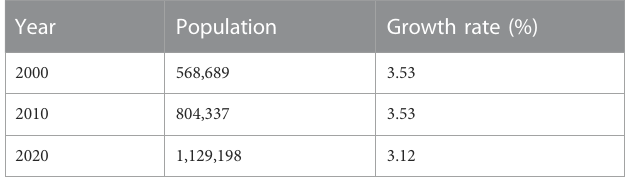
TABLE 1 Population and growth rate of Islamabad for the years 2000, 2010, and